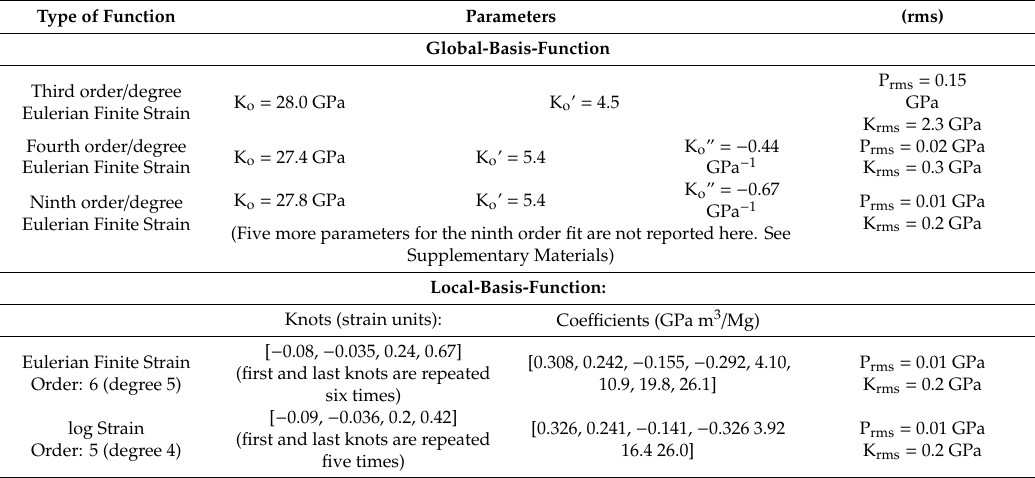
Table 2. Equation of state parameters and root-mean-square (rms) misfits of pressure (P rms ) and the bulk modulus (K rms ) for representations of the NaCl 0 K isotherm. A 1 bar density of 2.226 Mg / m 3 is used in all representations. Units for all parameters are